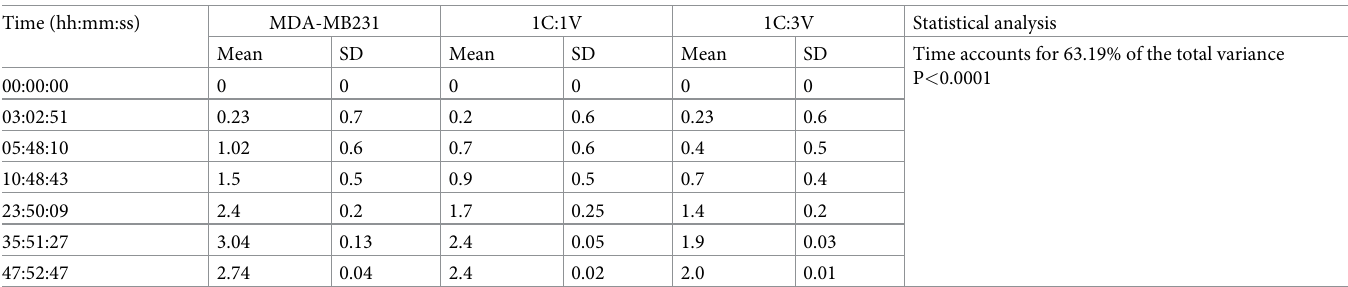
Table 1. The effect of CVMSCs on MDA-MB231 cells proliferation, in vitro, over 50 hour period (data represent a pool of 4 independent repeats). Time